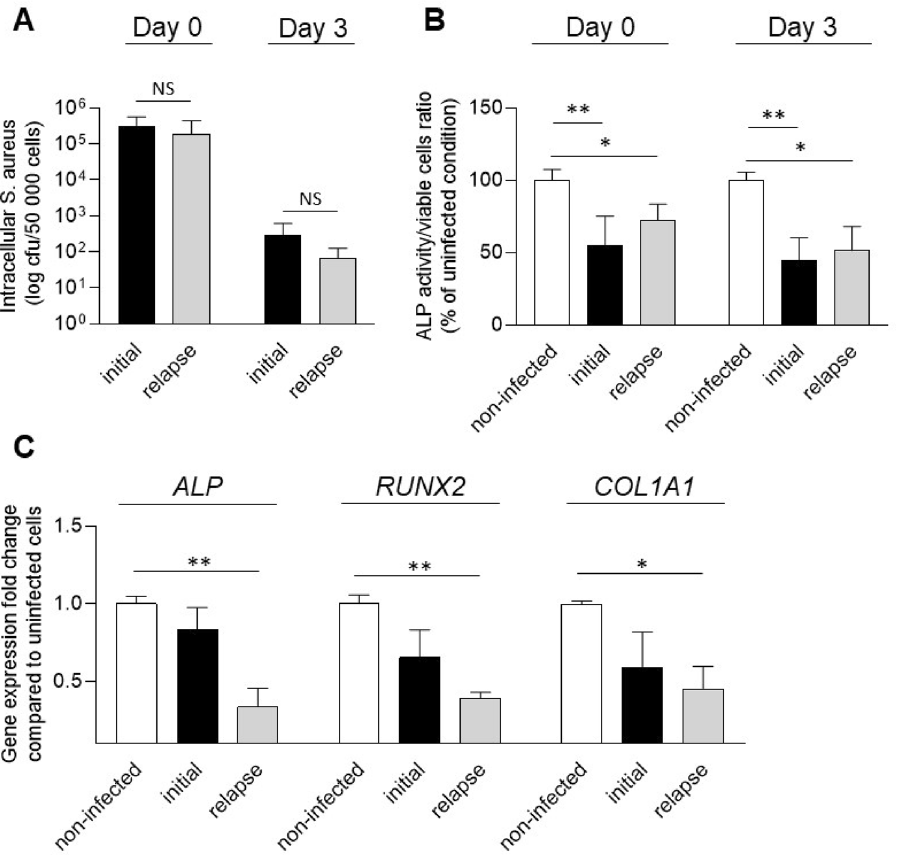
Figure 6. Effect of S. aureus clinical strains (initial and relapse) on the early differentiation of OBß1 cells. ( A ) Quantification of internalization and intracellular survival of S. aureus 8325–4 and 8325–4 ∆fnbAB into OBß1 osteoblasts. ( B ) Effect of S. aureus 8325–4, 8325-4 heat killed and 8325–4 ∆fnbAB on ALP activity. Results are expressed as a proportion of the activity detected for the non-infected condition. ( C ) Effect of S. aureus 8325–4, 8325-4 heat killed and 8325–4 ∆fnbAB on the expressions of ALP , RUNX2 , COL1A1 , expressed as a fold change compared to the non-infected condition. At least 2 independent experiments in technical duplicates were performed. * and ** mean P < 0.05 and P < 0.01